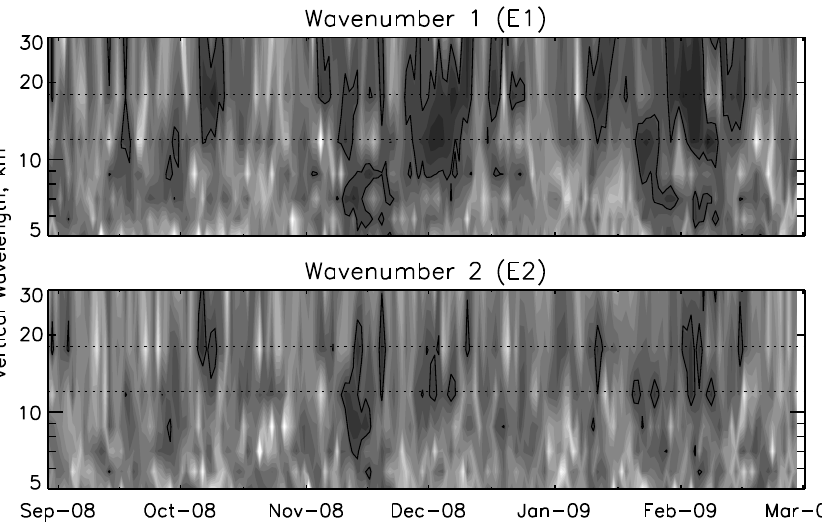
Fig. 7. Two-dimensional Fourier power at both wavenumbers from the wavenumber-vertical wavelength-power distribution during the period of interest. The thick black contours show the 95% confidence levels. The colour code is same as in Fig.